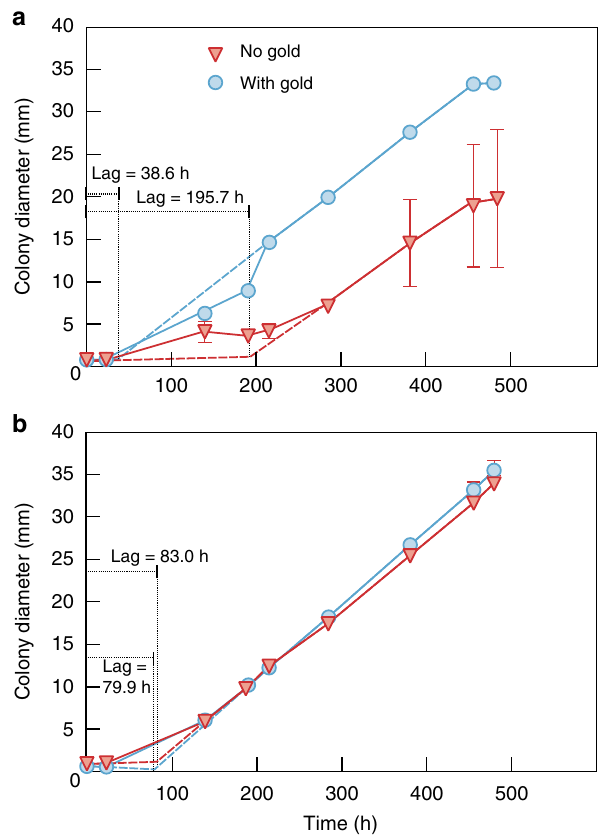
Fig. 5 Hyphal extension of TA_pink1. (a) sucrose and ( b) lignin as the sole carbon source. Error bars denote the standard deviation of the mean of triplicate measurements and are only shown when greater than the symbol dimension